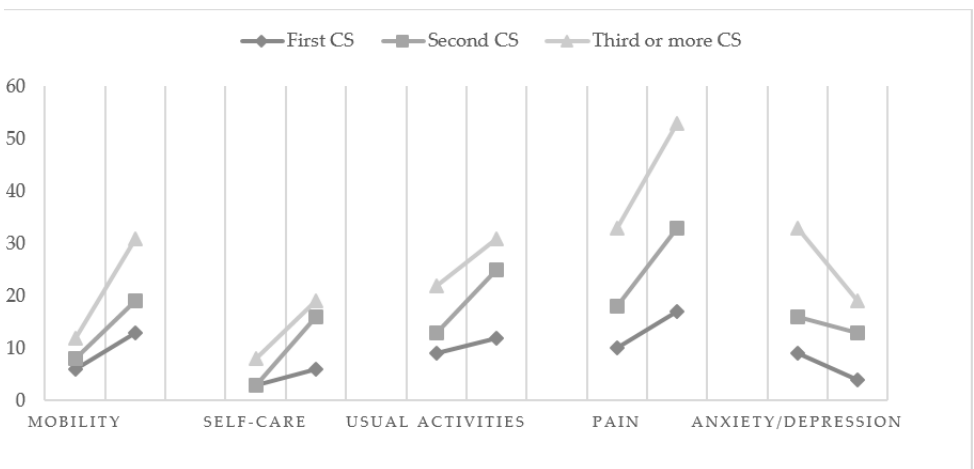
Figure 2. Any problems reported by the EQ-5D-3L dimensions in T1 and T2 ( n =